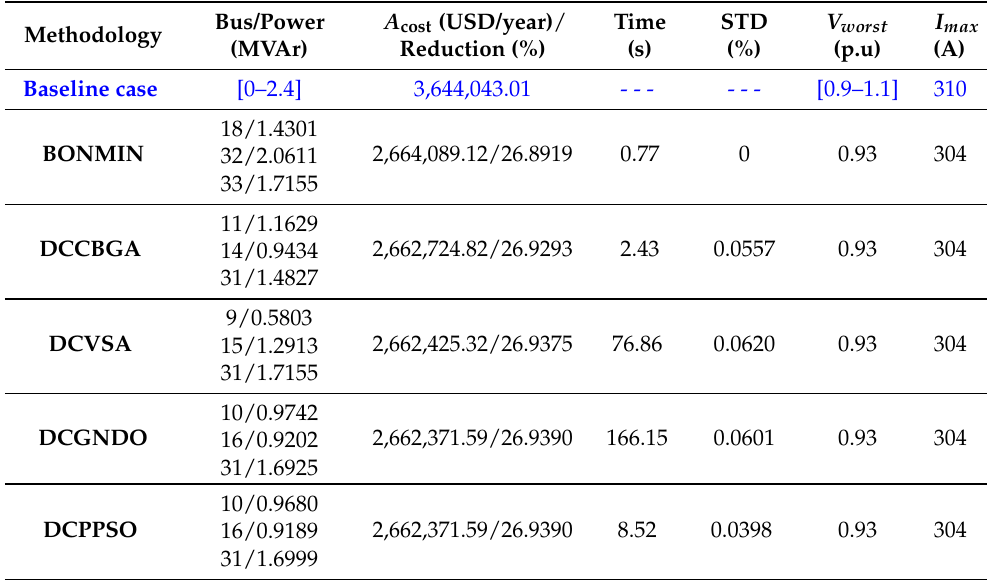
Table 3. Simulation results obtained via different methodologies in the 33-bus test system in both AC and DC